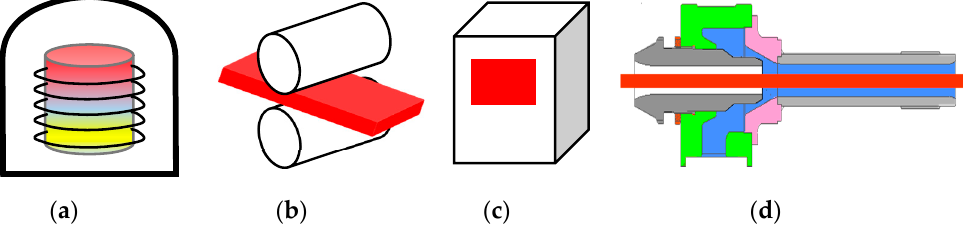
Figure 4. Sequential layout of Tempcore process simulator (TPS): ( a ) induction furnace; ( b ) pilot rolling mill; ( c ) box furnace; ( d ) cooling unit.